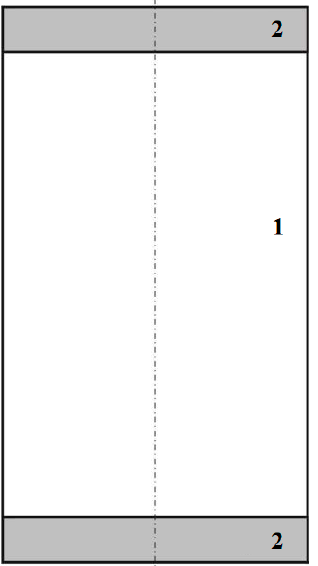
Figure 4. Schematically representation of surface test specimen.